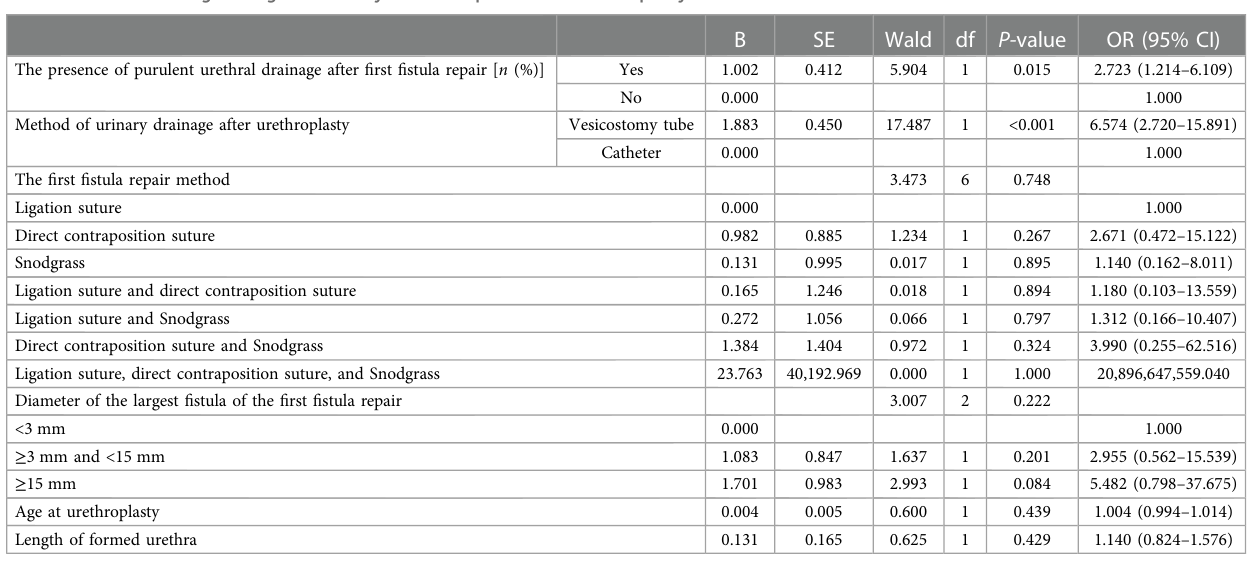
TABLE 3 Multivariate logistic regression analysis of multiple UF after